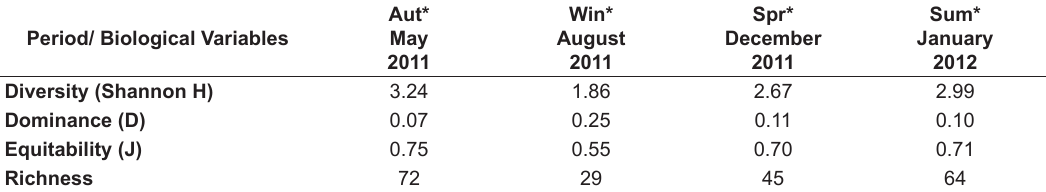
Table 2. Seasonal changes in the richness, dominance, equitability, and diversity of the diatom community in A . danaeifolium .